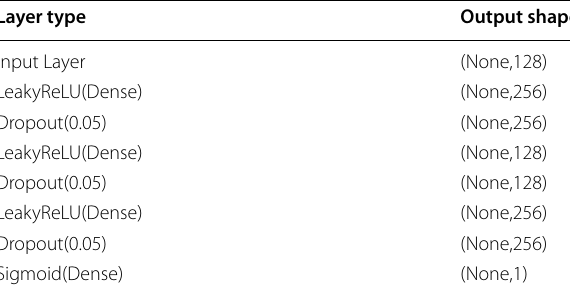
Table 4 The malware detector (MD) structure in